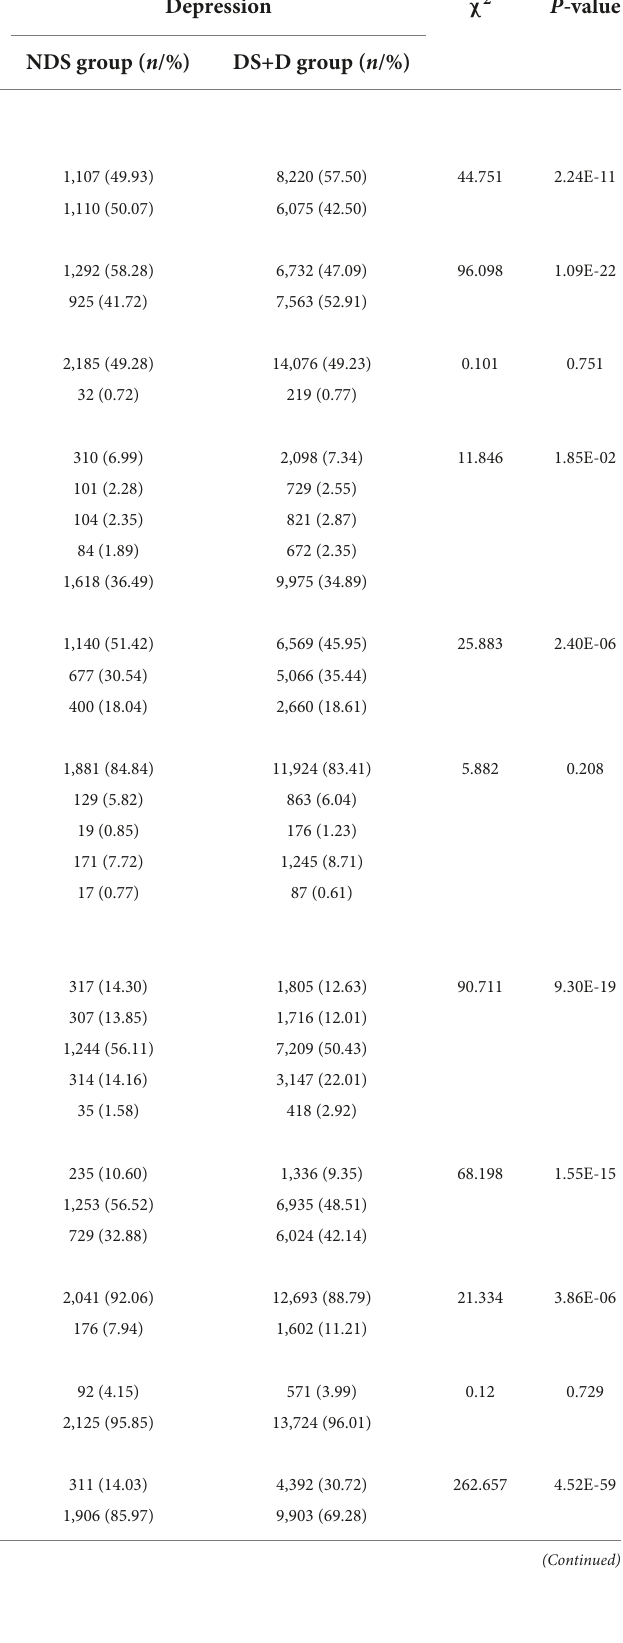
TABLE 2 Univariate analysis of independent variables on depressive